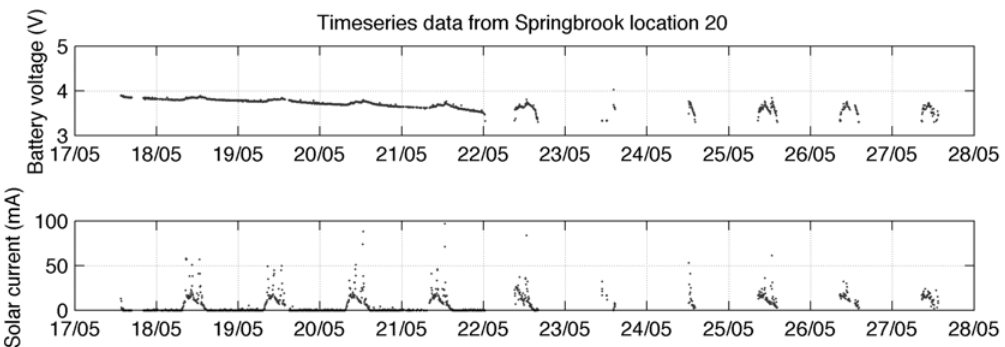
Figure 9. Solar current and battery voltage in partial sunlight [25].